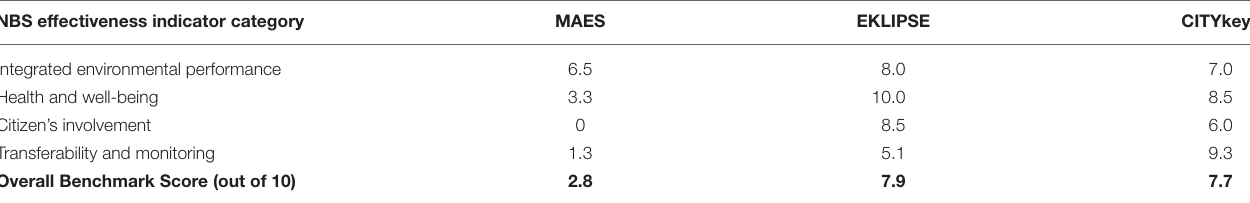
TABLE 3 | Summary of MAES, EKLIPSE, and CITYkeys assessment framework quantitative benchmarking against recommended indicators for evaluating the effectiveness of NBS for climate change adaptation and mitigation, and associated co-benefits (Kabisch et al.,